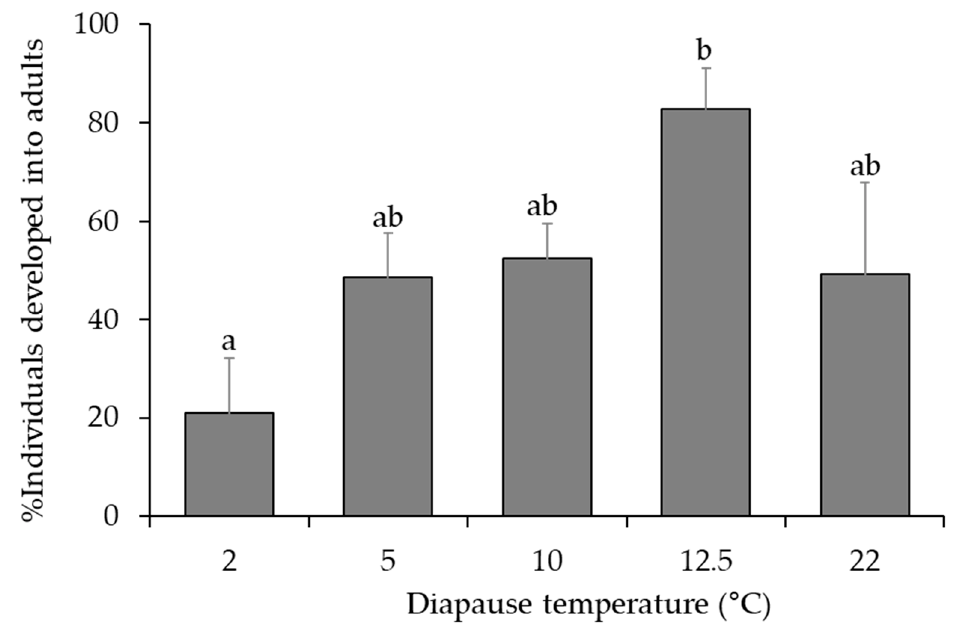
Figure 5. Effect of temperature regimes (see Table 1) on diapause survival of A. fukutai after being held for cold chilling in the dark and at 100% RH for 6–7 months or at normal rearing conditions continually (22 °C, 100% RH and 14L:10D). Bars are mean + SE and different letters above the standard error bars indicate significant differences (Tukey’s HSD, p < 0.05).